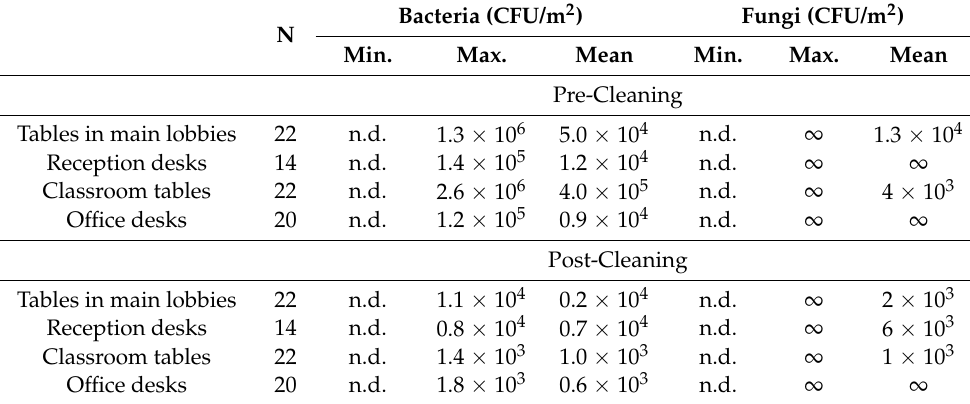
Table 2. Descriptive statistics of surface